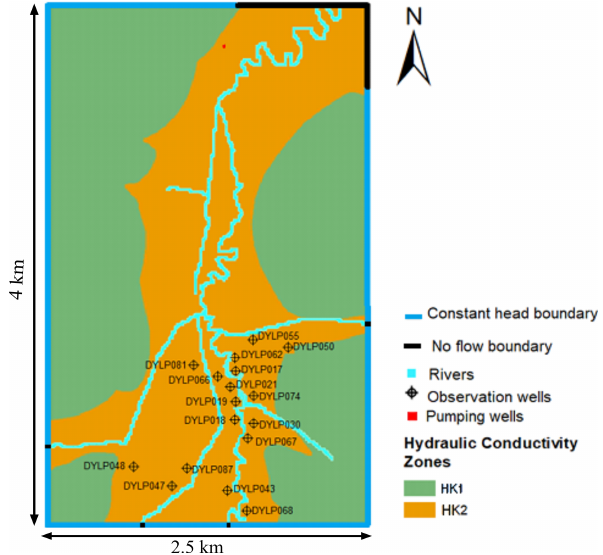
Figure 5. Conceptual model setup showing the specified bound- ary conditions and hydraulic conductivity zones with two distinct hydraulic conductivities: HK1 (Brussels sand formation) and HK2 (Quaternary loam